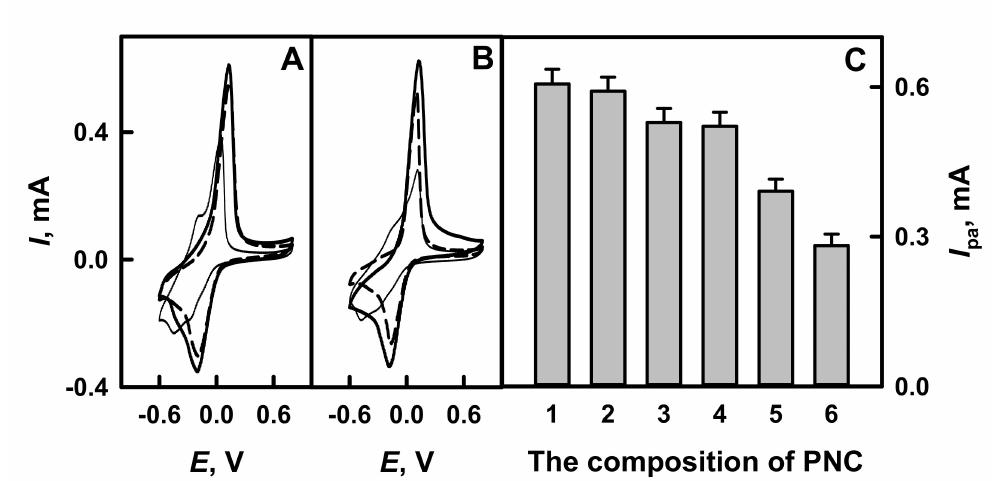
Figure 2. The cyclic voltammograms of GR electrode modified by PANI-GOx/GOx, PANI-AuNPs (6 nm) -GOx/GOx or PANI-AuNPs (6 nm) -GOx ( A ), Ppy-GOx/GOx, Ppy-AuNPs (6 nm) -GOx/GOx or Ppy-AuNPs (6 nm) -GOx ( B ) and the dia- grams of glucose biosensors based on GR electrodes modified by different composition of polymer nanocomposites ( C ). Conditions: ( A , B ) GR/PANI-GOx/GOx and GR/Ppy-GOx/GOx (dashed line), GR/PANI-AuNPs (6 nm) -GOx/GOx and GR/Ppy-AuNPs (6 nm) -GOx/GOx (solid line), GR/PANI-AuNPs (6 nm) -GOx and GR/Ppy-AuNPs (6 nm) -GOx (thin line); ( C ) GR/Ppy-AuNPs (6 nm) -GOx/GOx (1 column), GR/PANI-AuNPs (6 nm) -GOx/GOx (2 column), GR/PANI-GOx/GOx (3 column), GR/Ppy-GOx/GOx (4 column), GR/PANI-AuNPs (6 nm) -GOx (5 column) and GR/Ppy-AuNPs (6 nm) -GOx (6 column). Analytical signals were registered in 0.05 mol L − 1 SA buffer, pH 6.0, with 0.01 mol L − 1 KCl and 6.0 mmol L − 1 PMS by cyclic